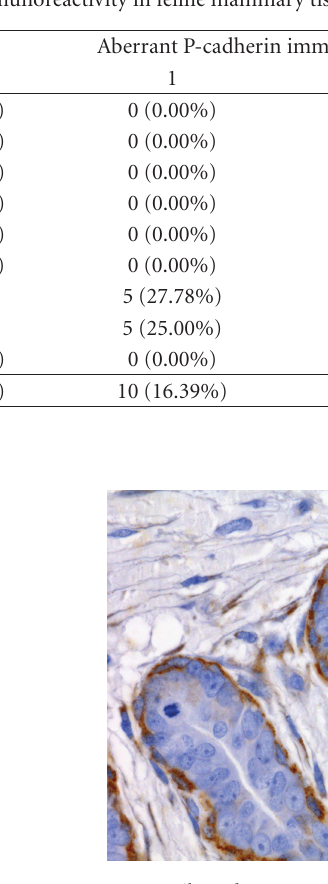
Figure 2: Fibroadenomatous change. Membranous and cy- toplasmic P-cadherin immunoreactivity in myoepithelial cells (streptavidin-biotin-peroxidase method, 630x).